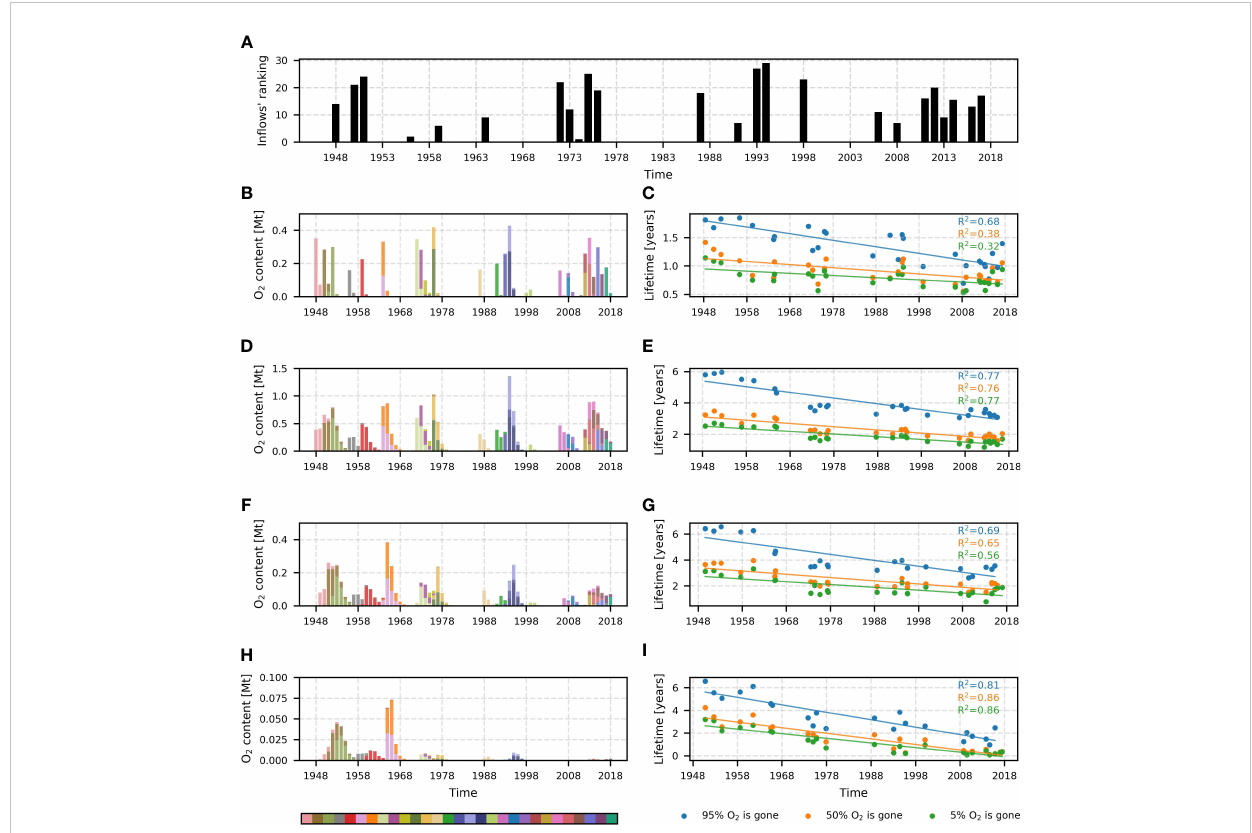
FIGURE 7 Ranking of in fl ows based on the total amount of oxygen transported across the Arkona transect during the in fl ow event panel ( A ). Number 29 stands for the in fl ow that transported the most oxygen, and number 1 for one that transported the least oxygen. The total yearly content of oxygen transported by saltwater in fl ows to different sub-basins is depicted in panels (B, D, F, H) . Different in fl ows are shown as different colors in the histogram. Bar heights represent the in fl ow ’ s O 2 content in a certain sub-basin. The color bar shows the colors of in fl ows in chronological order (the earliest in fl ow is pink, the next one is brown, etc.). Panels (C, E, G, I) show the lifetime of in fl ow oxygen for each sub-basin (dots). Lifetime is de fi ned as the time when in fl ow oxygen reaches a certain fraction of its maximal value. Three fractions are shown: 5% of in fl ow O 2 is consumed (95% remaining) - green dots, 50% of in fl ow O 2 is consumed (50% remaining) - orange dots, 95% of in fl ow O 2 is consumed (5% remaining) - blue dots. Linear trends, demonstrating the decay of in fl owing O 2 lifetime, are shown for each scatter plot. Determination coef fi cients (R 2 ) for each linear trend are presented in the upper-left part of the panels. Their colors indicate the trends they belong to. Panels (B, C) stand for Bornholm Basin, (D, E) – for eastern Gotland Basin, (F, G) – for the northern Gotland Basin, H and I – for the western Gotland Basin. Mt corresponds to 10 9